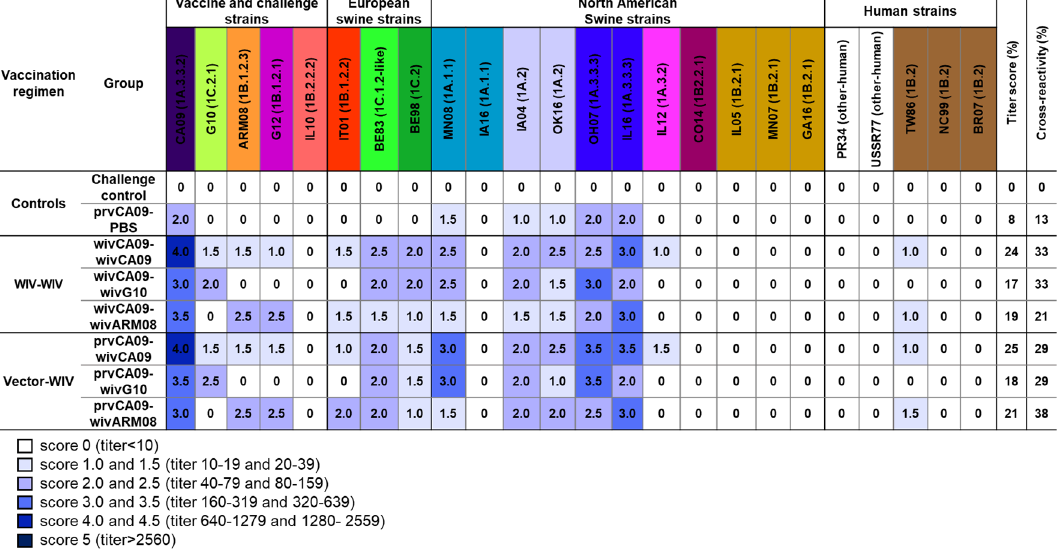
Figure 3. Hemagglutination inhibition (HI) titer scores against a panel of 24 H1 influenza A virus strains on the day of challenge. The virus strain colors are based on the HA clade, which is mentioned between brackets [1]. Each row represents the data generated with pooled serum from 1 vaccine group. Antibody titers were given a score from 0–4.5; the scoring system is explained below the figure. For each group, we calculated the cumulative HI titer scores (titer score; max. 120) and converted them to percentages. Additionally, we calculated the percentage of virus strains against which an HI titer score ≥ 2 was reached (cross-reactivity). See Figure 1 for full names of the virus strains. No IAV antibodies were detected in the mock-vaccinated challenge control group. The prvCA09–PBS group only had HI titer scores ≥ 2 against virus strains from clade